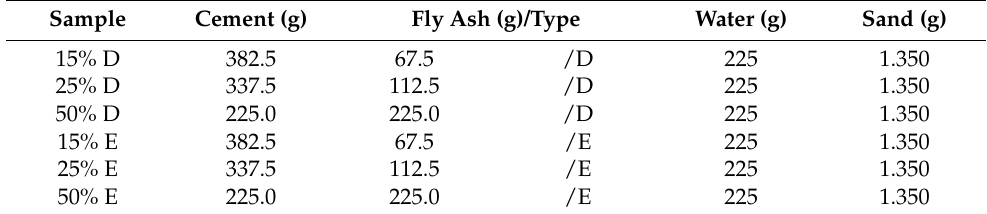
Table 6. Composition of mortars for the emission tests.